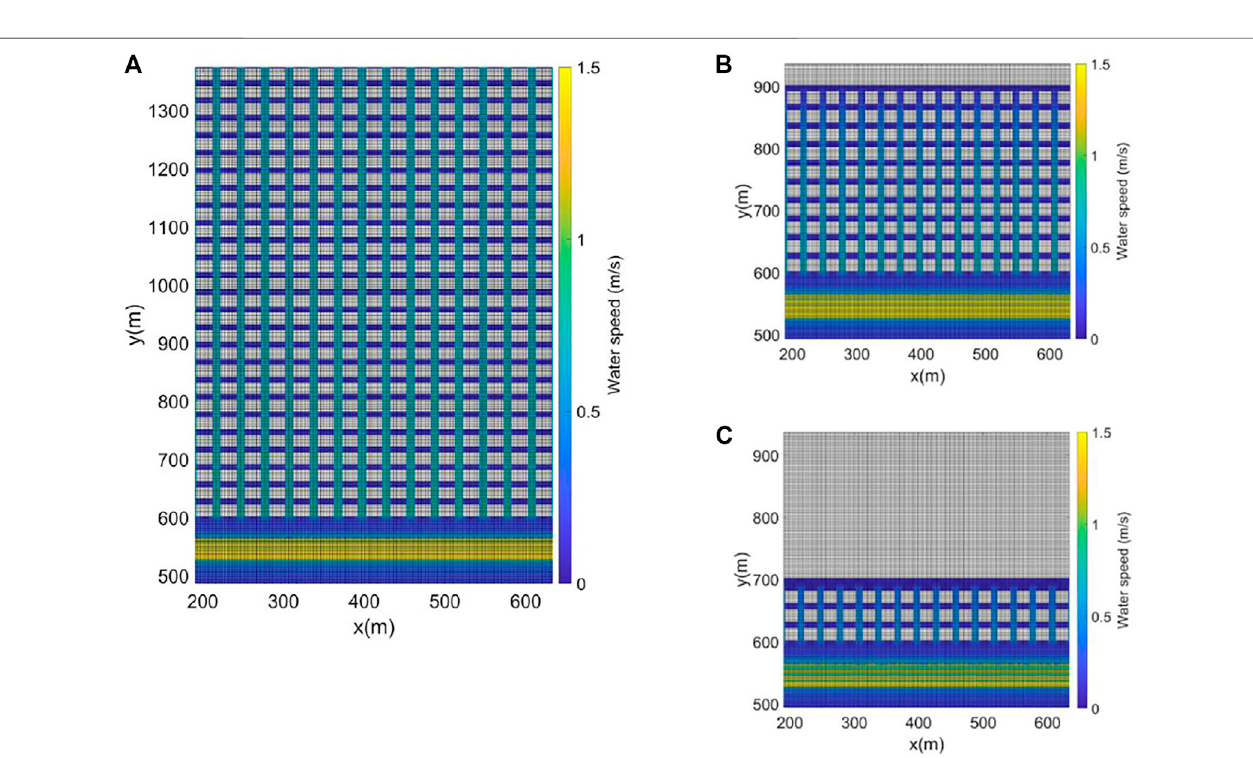
FIGURE8| TemporalmaximumwaterspeedinpartsofeachCLaNwhenprotectedbyaberm,withanaspectratioof (A) 1:1, (B) 3:1,and (C) 11:1underthe300- year fl ood condition and 0.5 m SLR. pattern — the water depth curve in the 11:1 CLaN increases from time ∼ 125 – ∼ 140 min with the steepest slope and the largest water rise rate among the three aspect ratio cases, whereas the 1:1 CLaN has the fl attest rising curve and the slowest rise rate. The model results suggest a 10 – 26% larger temporal maximum rise rate of 3: 1 and a 19 – 50% larger rise rate of 11:1 than the 1:1 CLaN. The difference among peak water depth across the full range of aspect ratios is always less than 10% with or without fl ood adaptation and regardless of SLR. For example, as shown for the